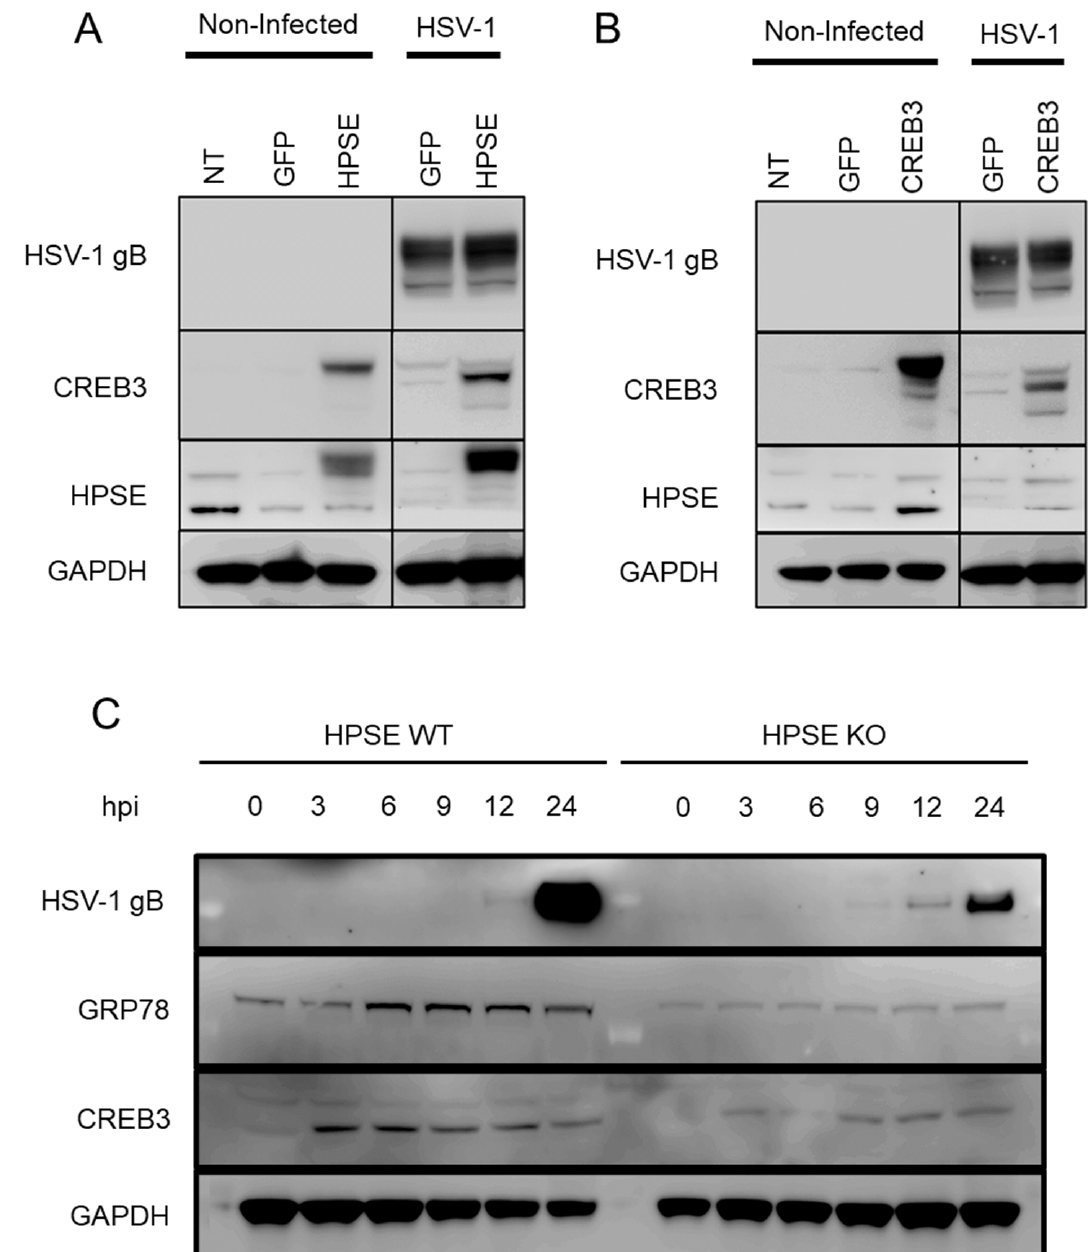
Figure 2. Upregulation of HPSE increases CREB3 expression: ( A ) Human corneal epithelial cells were transfected with a control plasmid, HPSE-GS3 (constitutively active form of HPSE), or full-length HPSE plasmid for 24 h followed by infection with HSV-1 at 0.1 MOI. At 24 h post infection, samples were collected for immunoblotting analysis. ( B ) Human corneal epithelial cells were transfected with a control plasmid or CREB3 plasmid for 24 h followed by infection with HSV-1 at 0.1 MOI. At 24 h post infection, samples were collected for immunoblotting analysis. ( C ) Heparanase wild-type or knockout mouse embryonic fibroblasts were infected with 0.1 MOI HSV-1 and cell lysates were collected at the indicated time points for immunoblotting analysis.